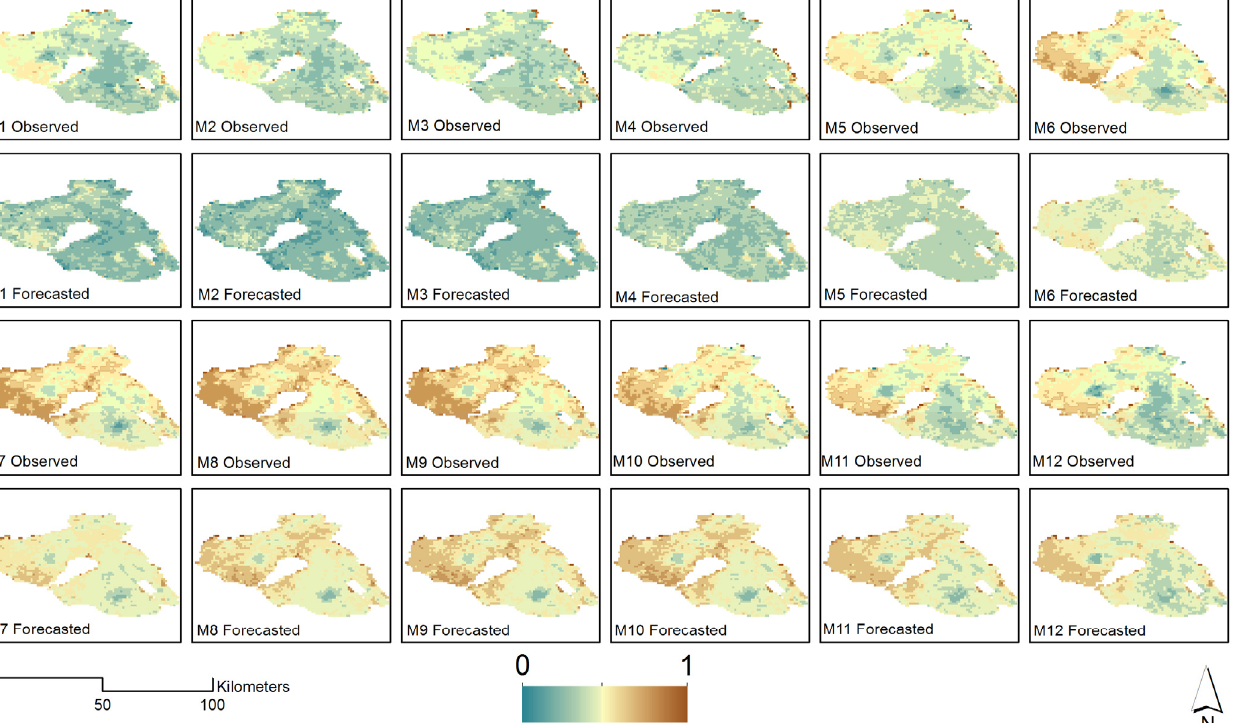
Figure 13. Spatial distribution of the difference between observed and forecasted NDVI of the vali- dation dataset. 4. Conclusions Understanding vegetation dynamics and taking necessary protective measures is crucial for Mediterranean ecosystems, given the number of major disturbances such as wildfires and droughts, as a result of man-made activities in the areas affected, limiting the ecosystem’s regeneration. In the present study, we forecasted the Normalized Differ- ence Vegetation Index (NDVI) based on NDVI time-series data derived from the Moderate Resolution Imaging Spectroradiometer (MODIS). The proposed approach combines the DTW technique, optimal fuzzy clustering and long short-term memory (LSTM) neural